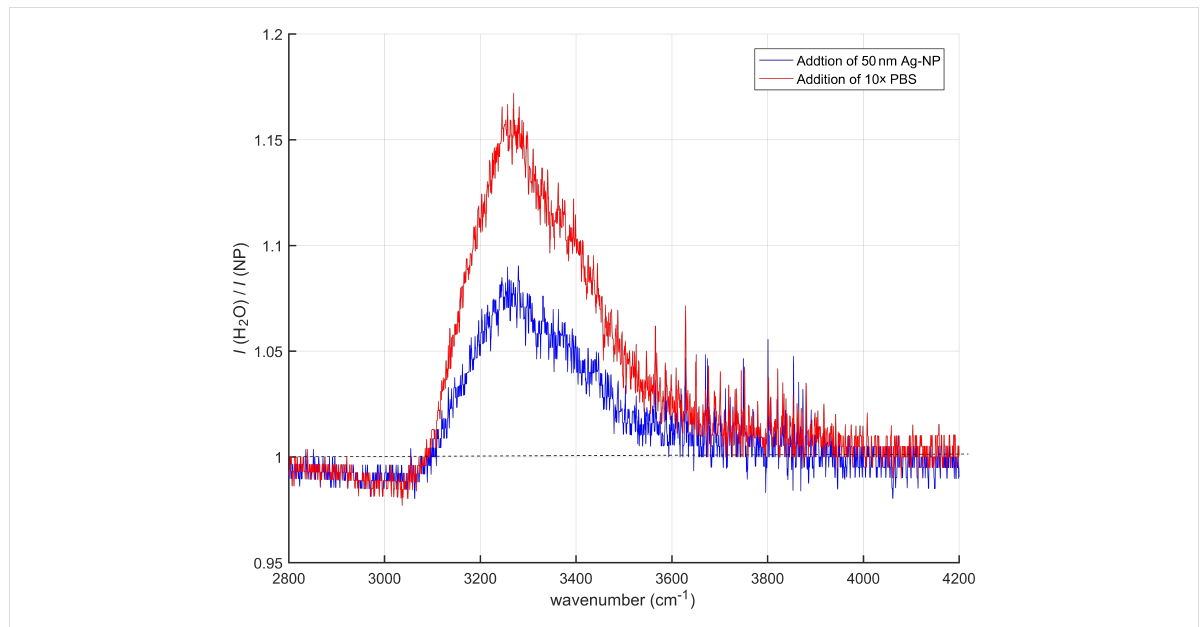
Figure 2: Amplification of water OH-stretching band (measurements with the polycarbonate sensor).